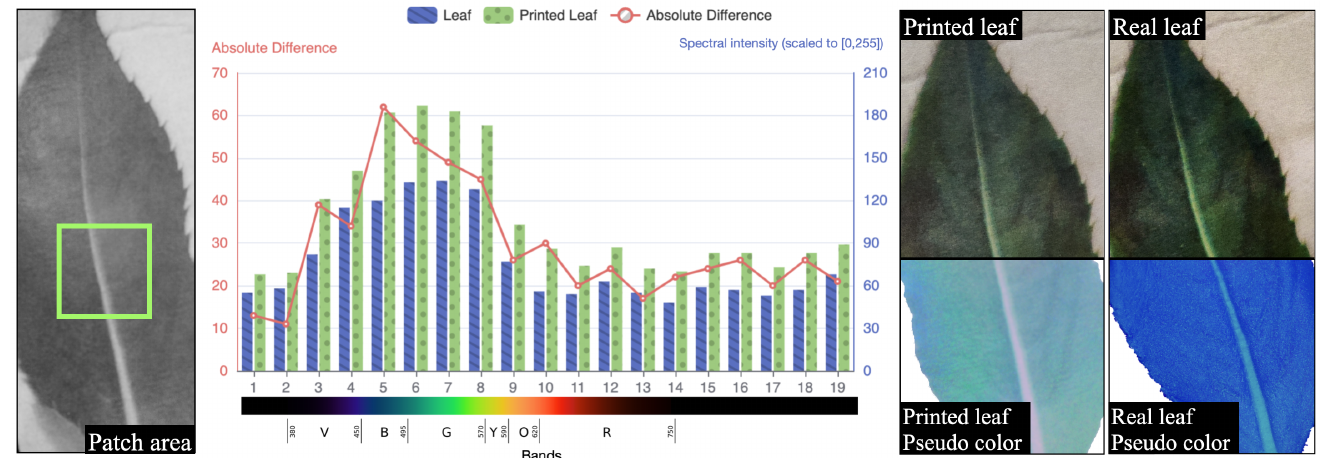
Figure 10. The spectral analysis between the printed and real leaf from the same patch area. The combined image shows the spectral analysis between the printed and the real leaf (image collage on the right) from the same patch area (leftmost image). The chart highlighting spectral analysis (image at the center) is the same as Figure 8. The comparisons between the printed (second to the extreme right image) and real (rightmost image) leaves are made with RGB images, and the most distinct bands (5, 6, and 7) of the pseudo-colored